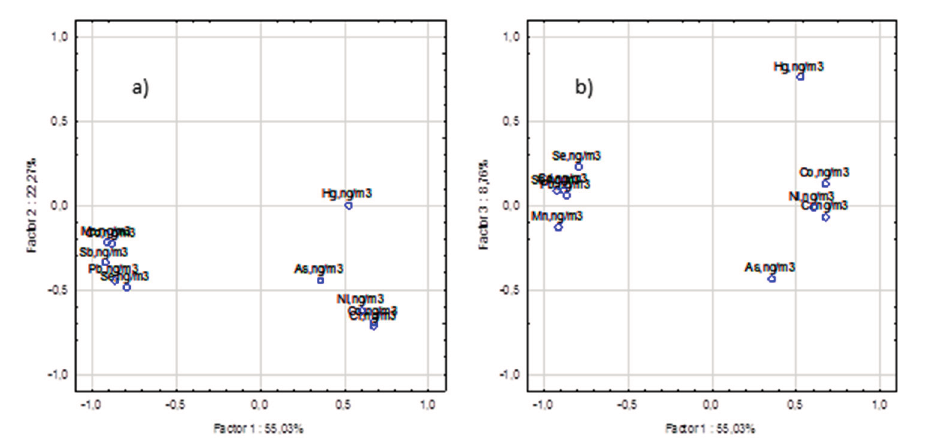
Figure 5. The scatterplot of the loading factors for Fraction 3. ( a ) for the first and second principal components; ( b ) for the first and third principal components projection of variables according to the principle component analysis